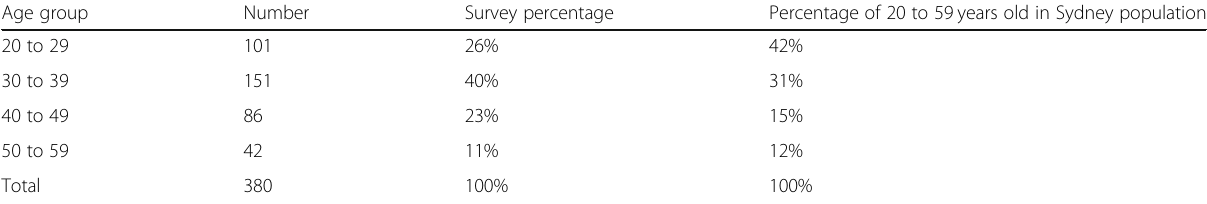
Table 1 Age description of the Sydney survey sample Age group